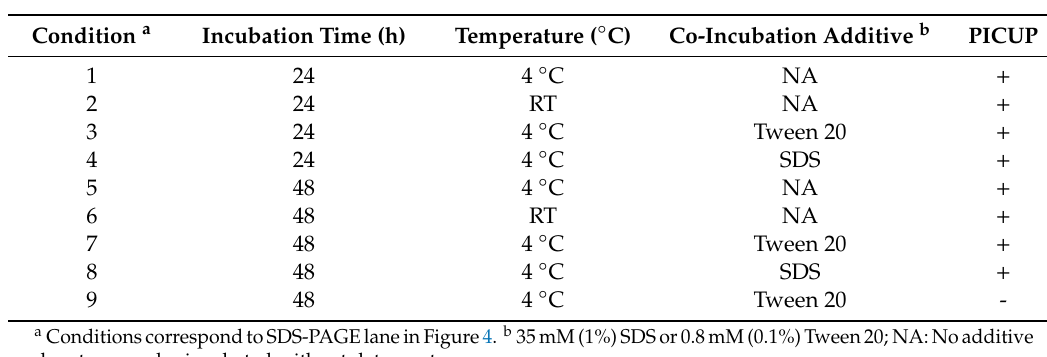
Table 1. A β (M1–40) oligomer incubation conditions.